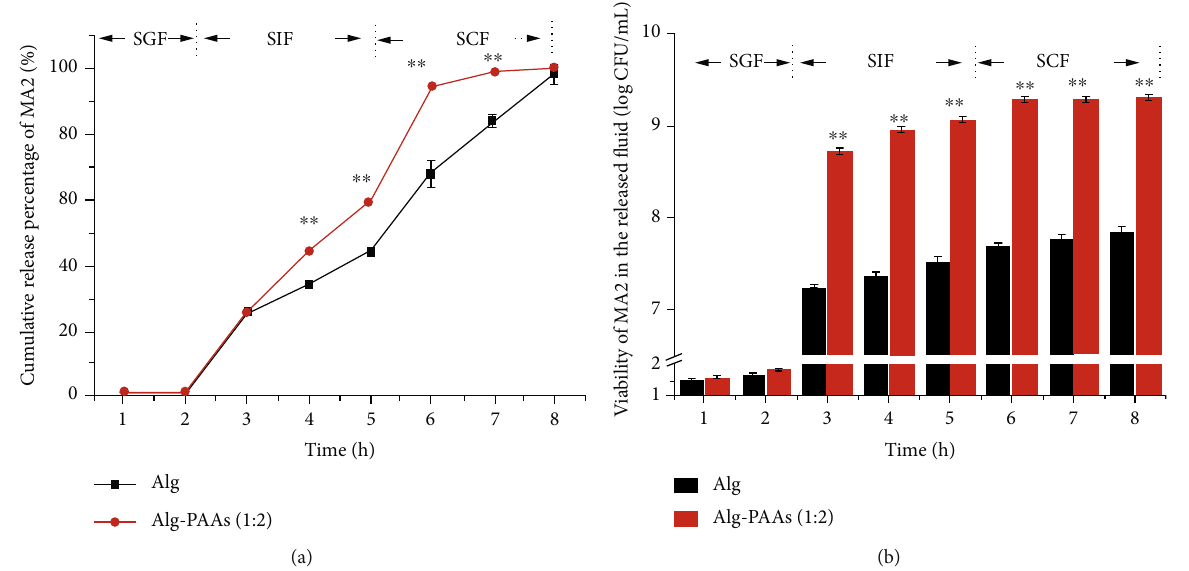
Figure 66: The release of L. plantarum MA2 in stimulated fl uid. Alg or Alg-PAAs (1 :2) microcapsules was immersed in SGF (pH2.0, 2 hours), SIF (pH 6.8, 3 hours), and SCF (pH 7.4, 3 hours), consecutively. (a) Cumulative release percentage of L. plantarum MA2. (b) Viability of L. plantarum MA2 in the released fl uid. Data were present as means ± SD , n = 3 , ∗∗ p < 0 : 01 [181].